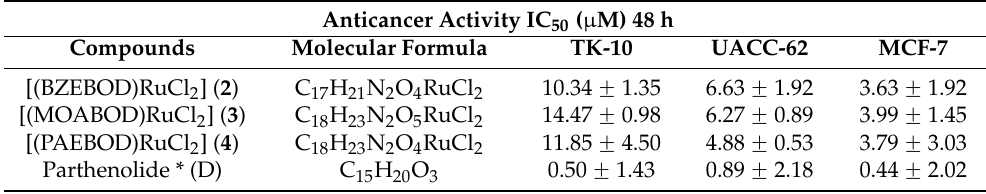
Table 2. IC 50 values ( µ M) of heterocyclic Ru(III) compounds and Parthenolide against human cell lines.